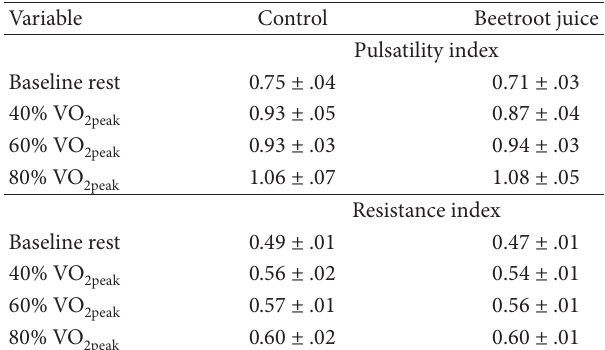
Figure 3: Effects of beetroot juice treatment on total vascular resistance. Bars represent means ± standard errors for total vascular (peripheral) resistance computed as the ratio mean arterial blood pressure/cardiacoutput,expressedindyne ⋅ s ⋅ cm −5 .Thesubjectswere 12 healthy, normotensive young adult African-American females. Left panel: placebo control orange juice treatment. Right panel: beetroot juice treatment. ∗ Difference between control and beetroot juice treatments statistically significant at 𝑃 < 0.05 . Table 4: Effects of beetroot juice treatment on TCD pulsatility and